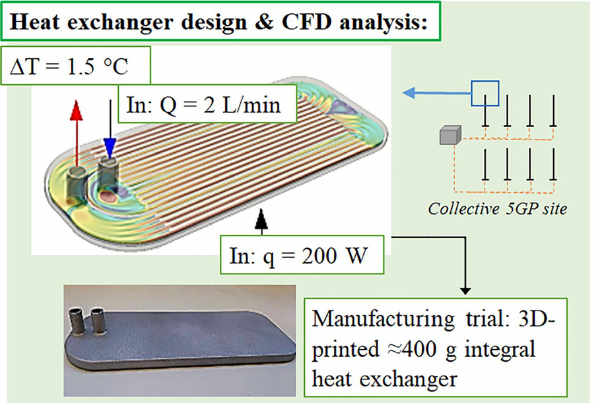
Figure 7. The cooling design for an integral device configuration in the smart pole(s): the estimated input data for thermal analysis of a heat exchanger by using